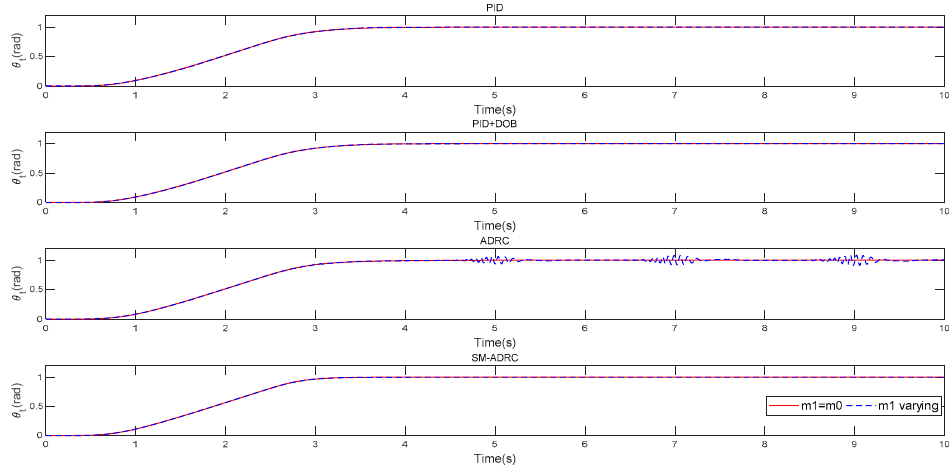
Figure 7. Tracking trajectories of the flexible manipulator tip position with the tip mass varying.